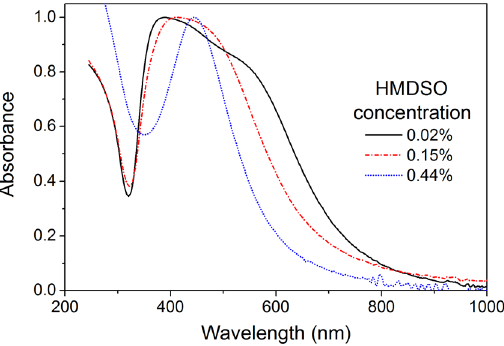
Figure 5. UV-Vis spectra of the core-shell nanoparticles prepared by GAS at different concentrations of itself to the controlled fabrication of other complex functional nanoparticles.